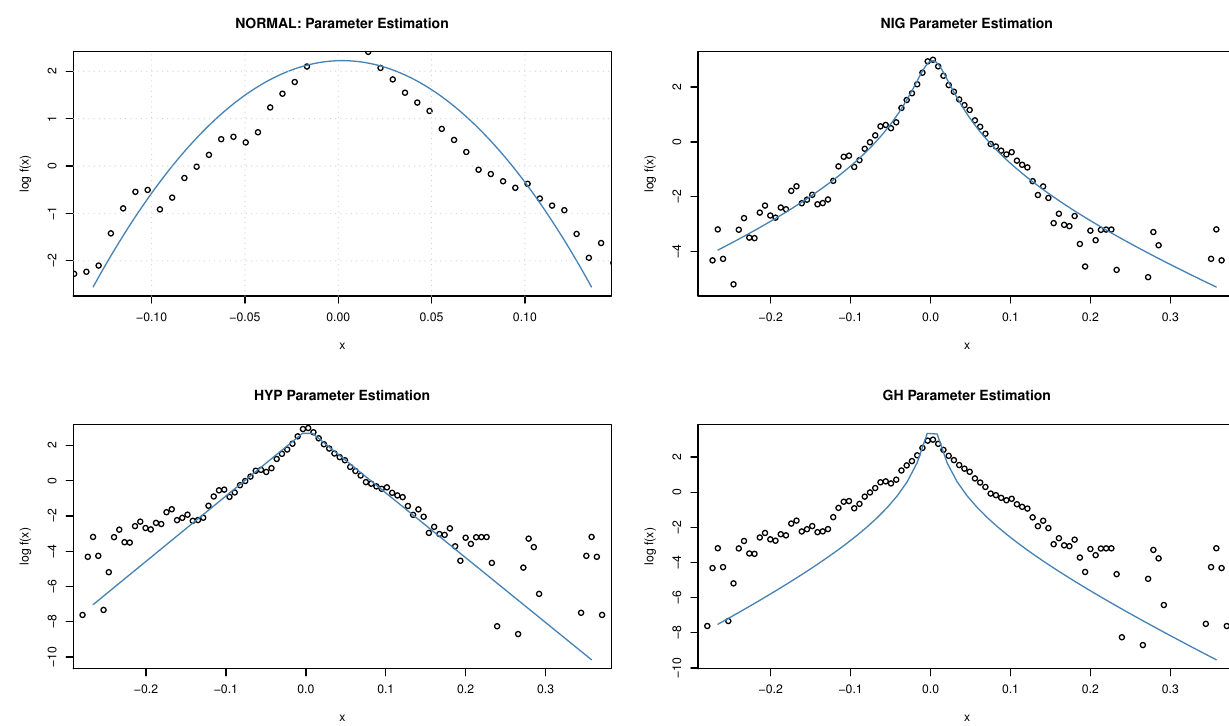
Figure 2. Fitted densities on the log-scale for the series of Bitcoin